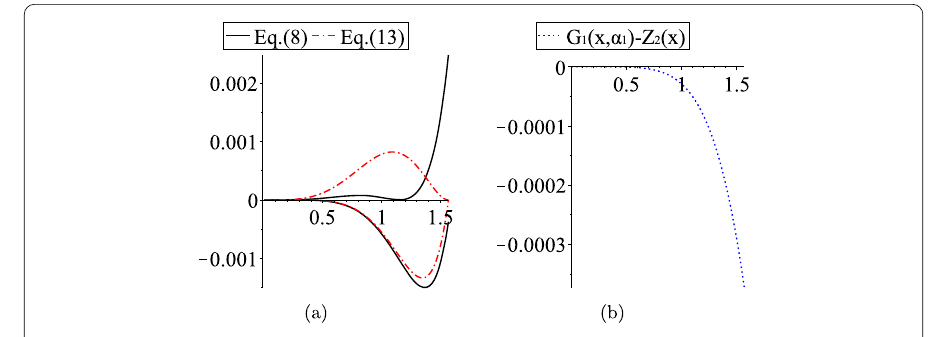
Figure 1 Error plots of ( a ) bounds from Eq. (8) (in solid black) and Eq. (14) (in dashed red), and ( b ) Z